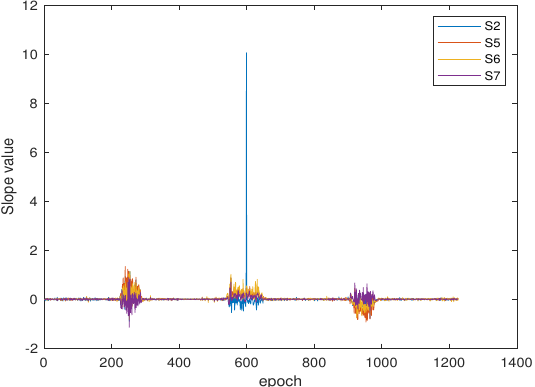
Figure 14. Slope values between epochs.